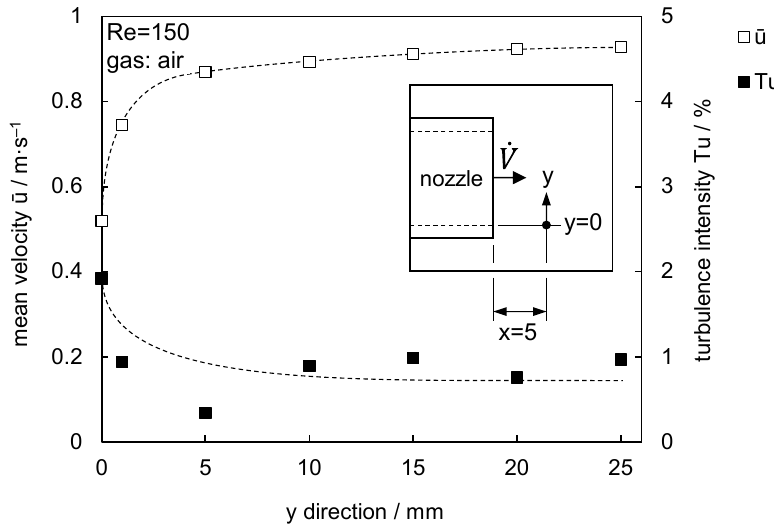
Figure 6. Mean velocity of flow over nozzle width.